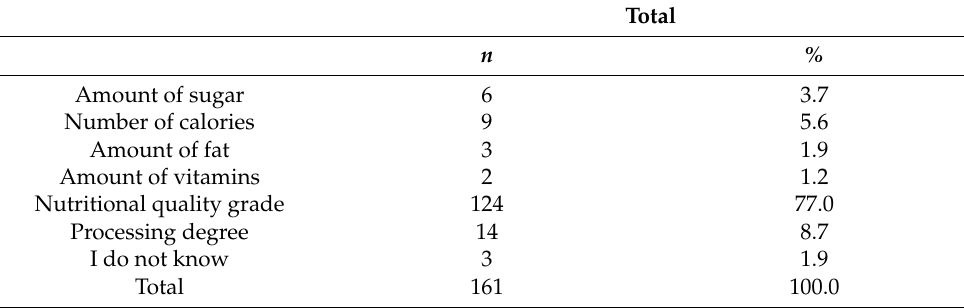
Table 8. Interpretation of the Nutri-Score